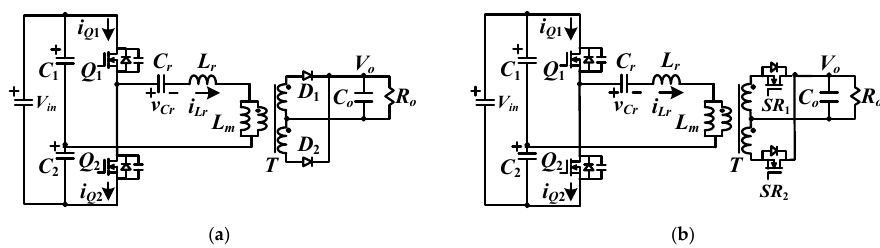
Figure 1. Circuit diagram of conventional resonant converter with ( a ) center-tapped rectifier on the secondary-side ( b ) with synchronous rectifier on the